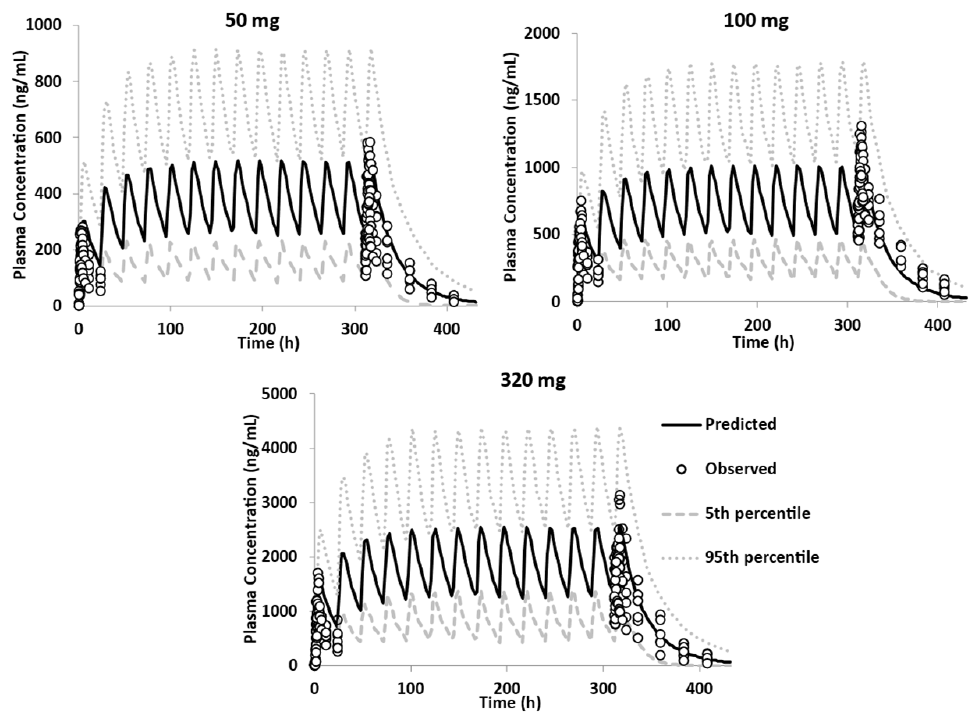
Figure 10. Performance verification of the PBPK model in fed state using the DLM model; overlay observed individual data from FTIH MAD–50, 100 and 320 mg—tablet—single dose daily after a moderate–high fat meal [1].